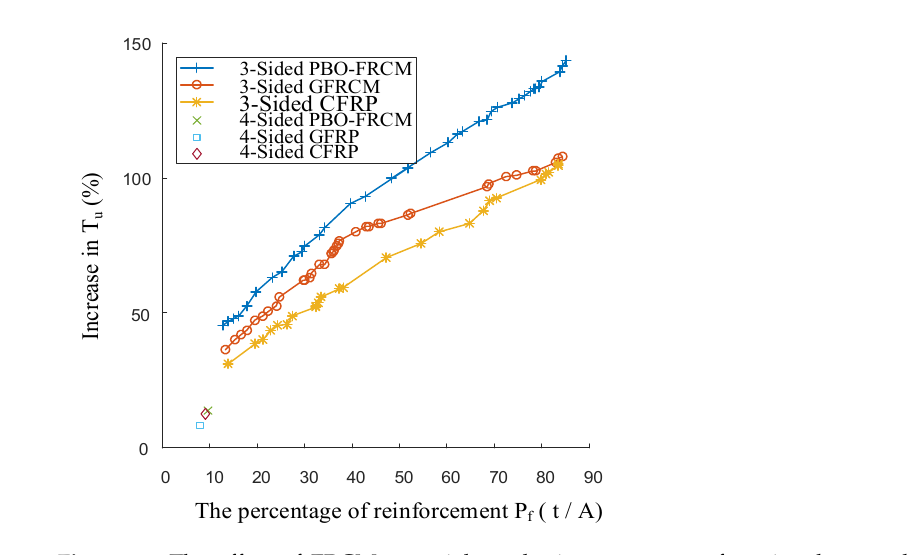
Spherical bearing steel Applied load Supporting beam Figure 5. Experimental test setup under torsional behavior.